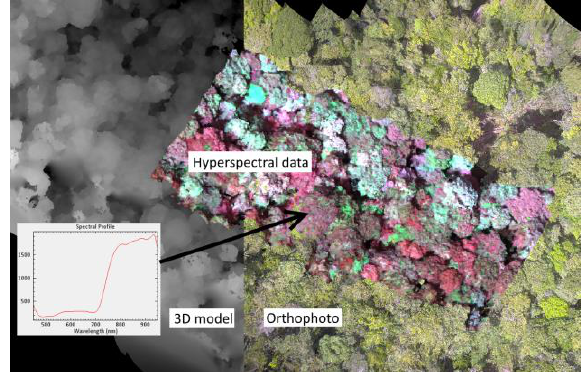
Figure 4. Fused RGB, 3D structure, and hyperspectral data of